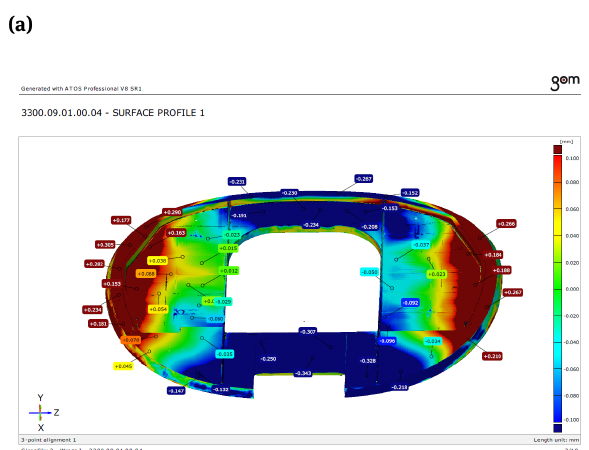
Figure 4: The maps of the linear dimensions and displacements of the frame elements after the mechanical machining: a) top side, b) bottom